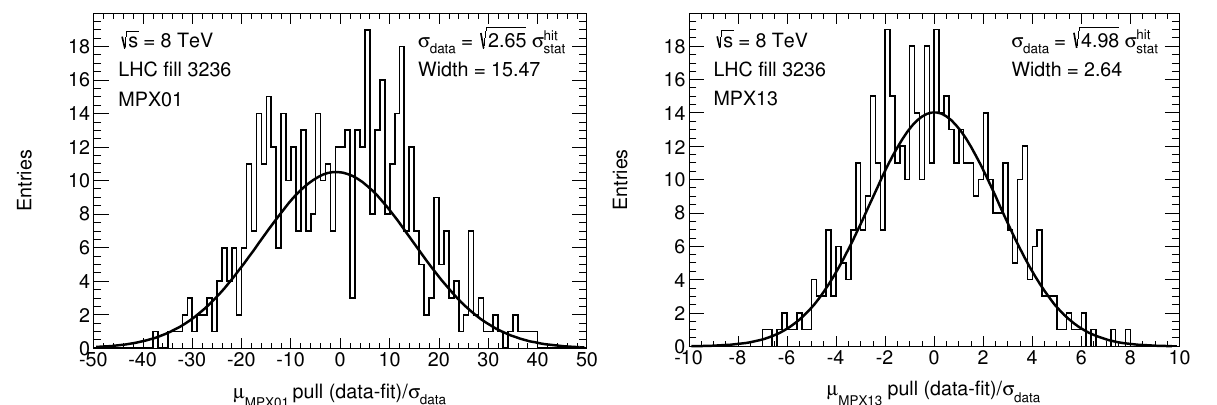
√ R · σ hit . The ratio R = N hit / N cl is determined for stat